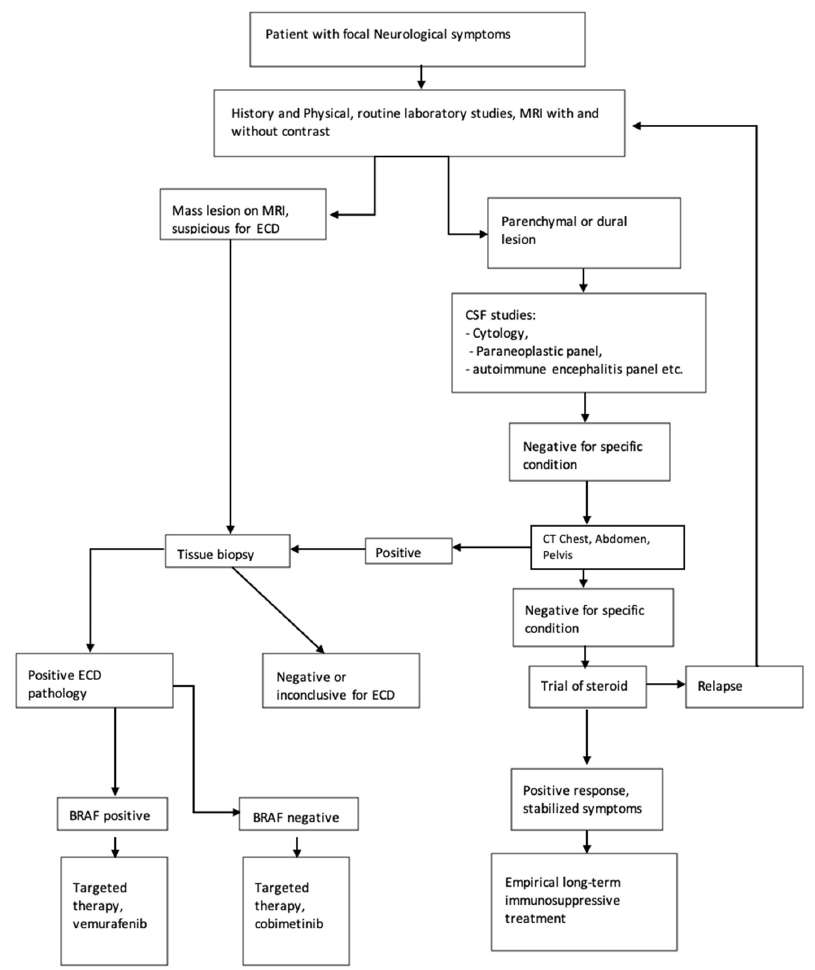
Figure 3. Proposed algorithm for work-up of patients presenting with focal neurological symptoms; recommended testing if ECD is suspected. Positive ECD pathology–histopathology indicative of ECD diagnosis; positive response—no further symptom progression or resolution of symptoms; stabilized symptoms—no further progression of symptoms.